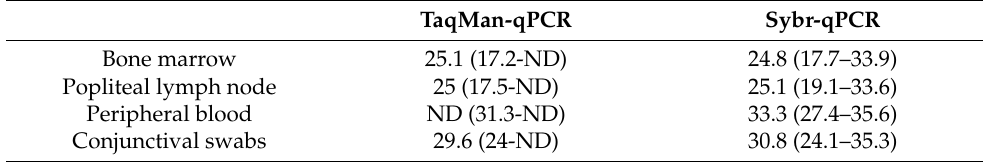
Table 2. Median, minimum, and maximum Ct values in the different biological samples